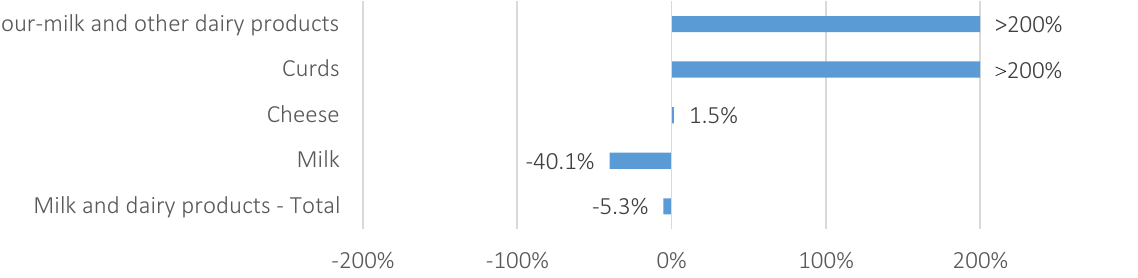
Figure 5. Average consumption for segment